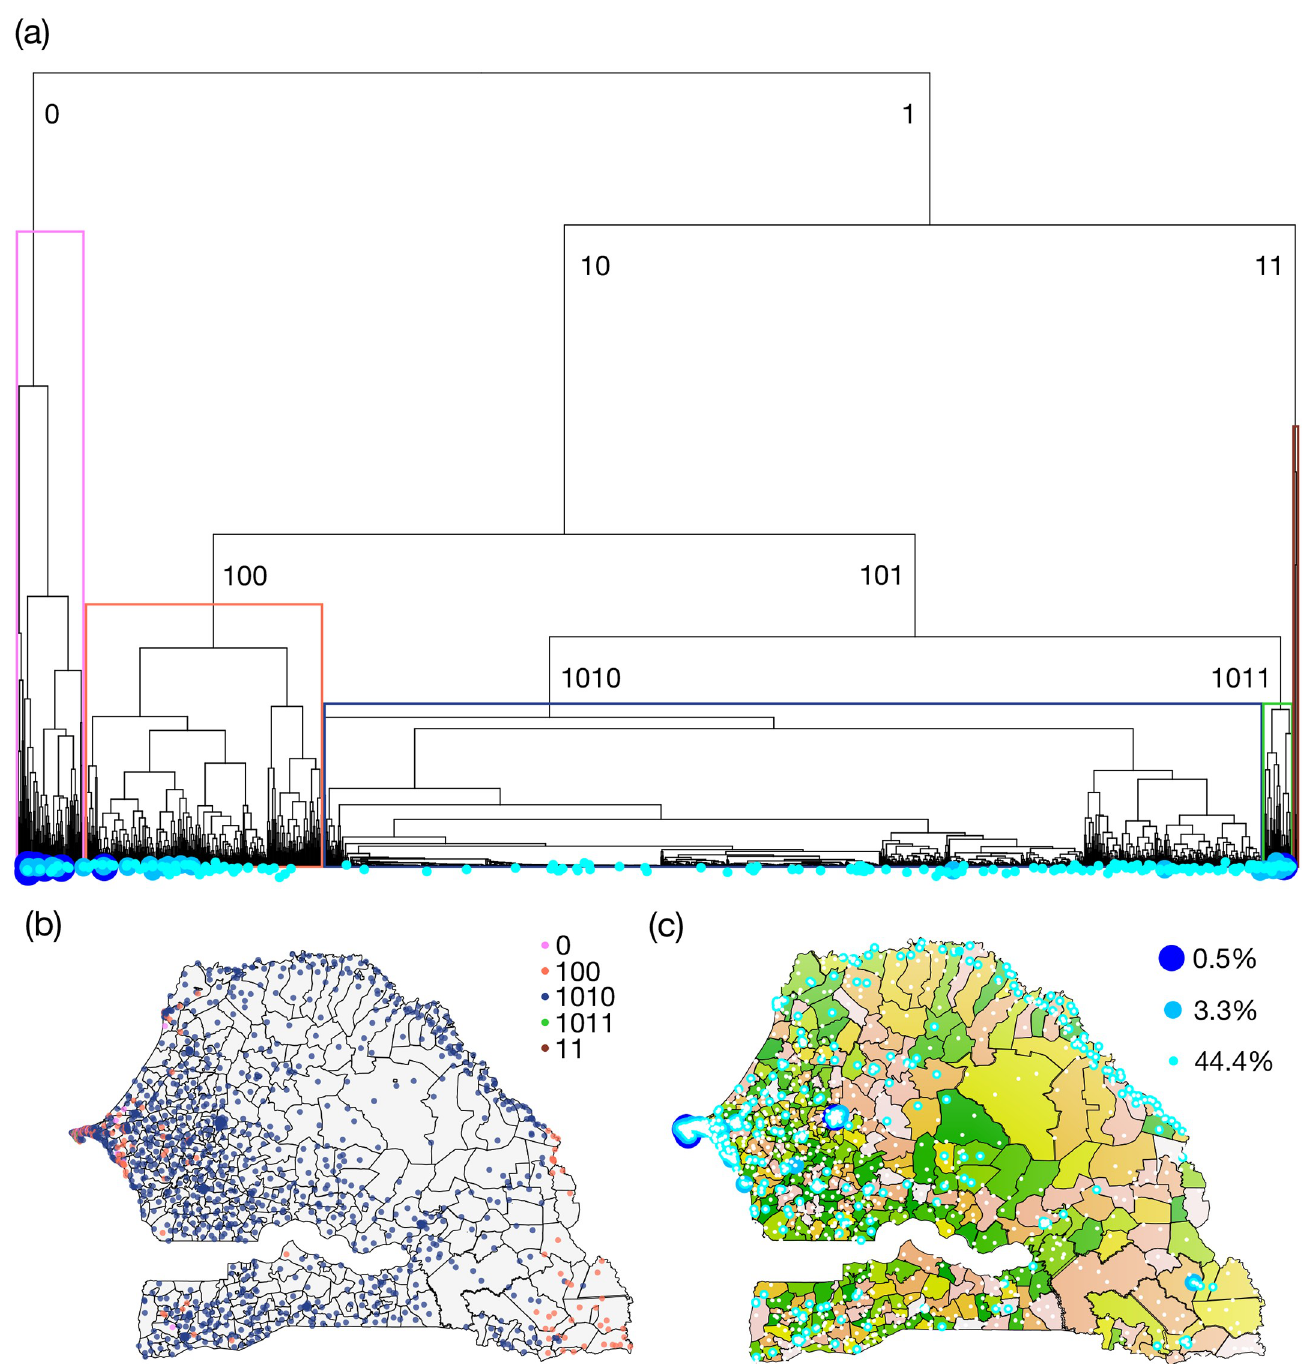
Fig 2. Description of the tree cutting process. (a) Tree corresponding to the daily number of texts. The branches are identified by a binary number. (b) Locations of the members of five clusters identified on the tree. (c) Locations of one randomly chosen element per branch of the tree cut at depth 3 (dark blue), 7 (medium blue) and 19